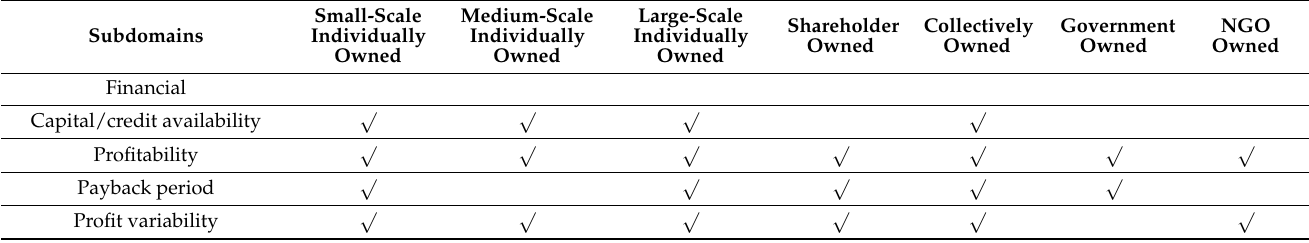
Figure 3. Diversity of subdomains considered across all respondents and farming business ownership models. Table 5. Subdomains considered across farming business ownership models.